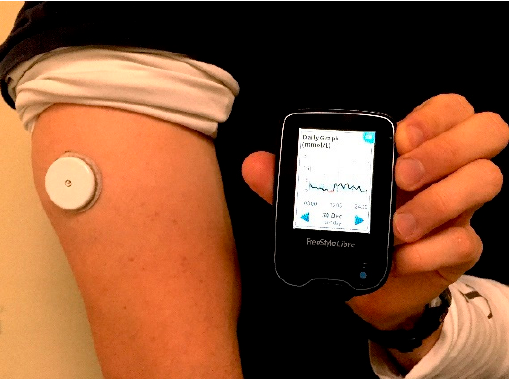
Figure 2. Abbott’s continuous glucose monitoring biosensor; https://diatribe.org (accessed on 9 October